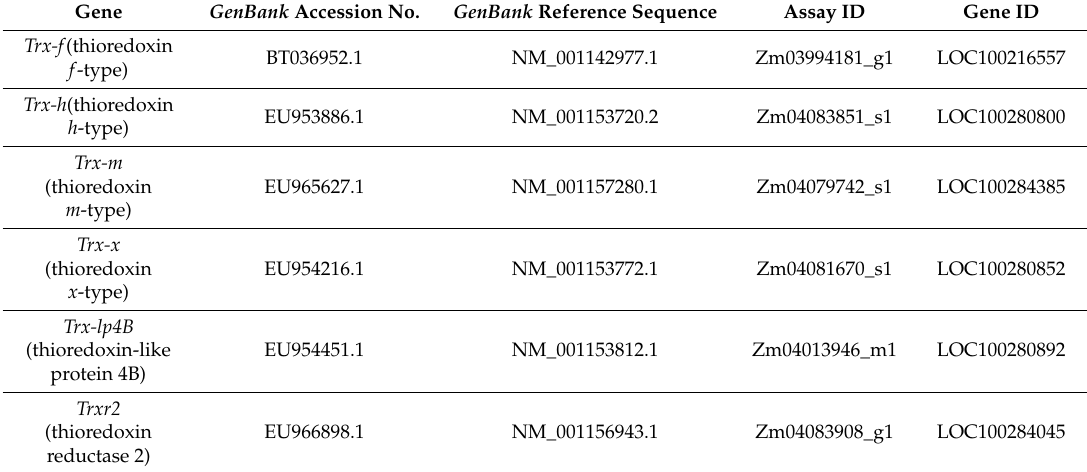
Table 2. The list of the quantified maize genes and TaqMan Gene Expression Assays 1